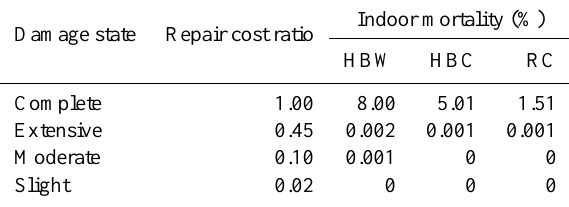
Table 4. The repair cost ratios and indoor mortalities for different damage states of buildings.